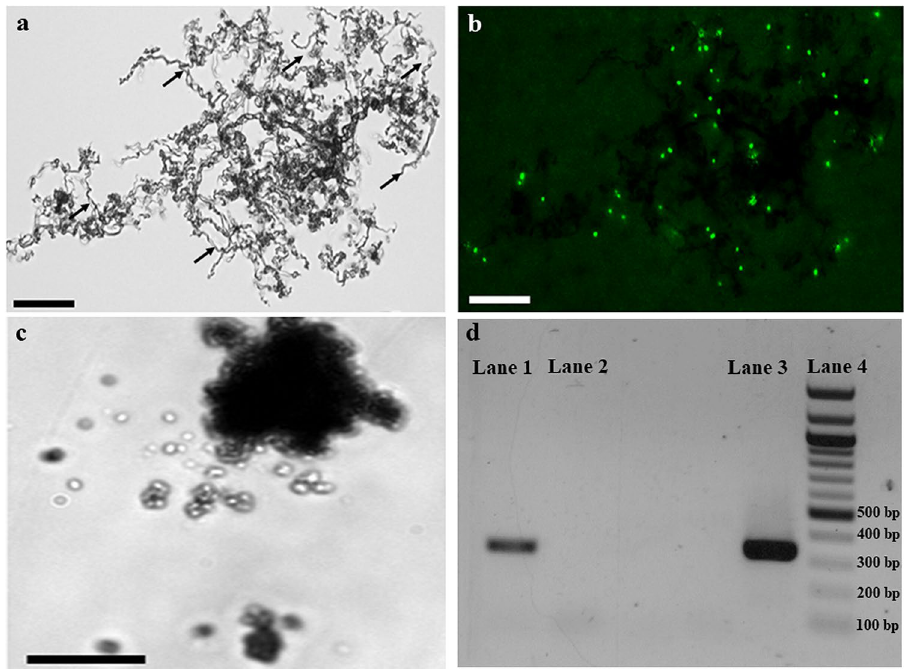
Figure 1. Transformation of M. ferrooxydans . Successful transformation of pRK2m3 (empty vector) into M. ferrooxydans was confirmed by ( a ) growth in the presence of 200 µg/mL kanamycin as shown by the production of characteristic stalk formation (black arrows) in the bright field micrograph and ( b ) an epifluorescent micrograph of the same field showing cells stained with Syto 9. ( c ) Wild-type cells were unable to grow or produce stalks in the presence of 200 µg/mL kanamycin and only formation of amorphous iron oxyhydroxides was observed. Scale bars indicate 25 µm. ( d ) Electropherogram showing amplification of pRK2m3 specific DNA fragment using DNA extracted from the transformed cells after ten transfers in the presence of 200 µg/mL kanamycin (Lane 1), and purified pRK2m3 (Lane 3) as the template. Template DNA containing DNA extracted from the wild-type cells did not produce any amplification (Lane 2). Lane 4 is a DNA